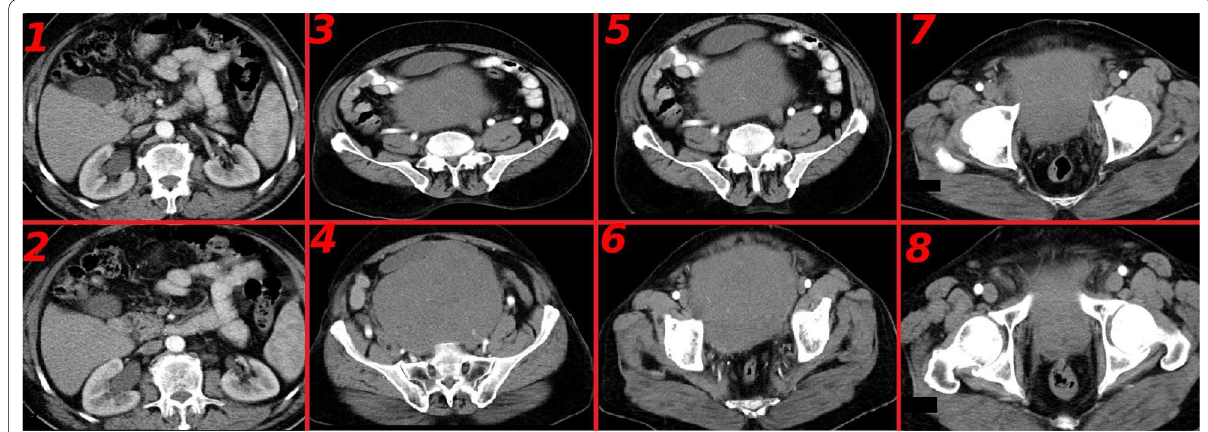
Fig. 1 Computed tomography scan showing the huge prostate upon bladder. At 1–2: upper urinary tract; 3–4–5: prostate pushed bladder anteriorly; 6–7–8: huge prostate extending inferiorly